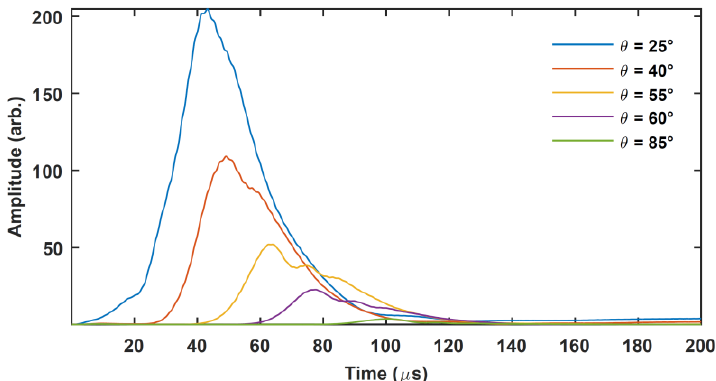
Figure 12. Pulse compression outputs for the sample of Figure 11 at various transducer separation angles θ .